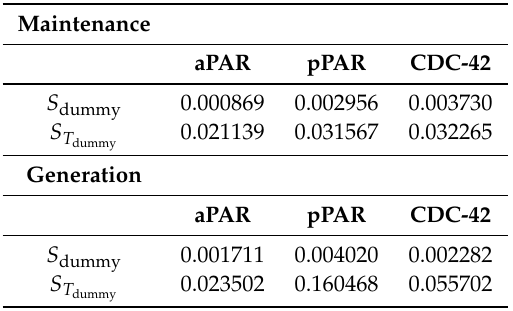
Table A3. First order index and total index for the dummy